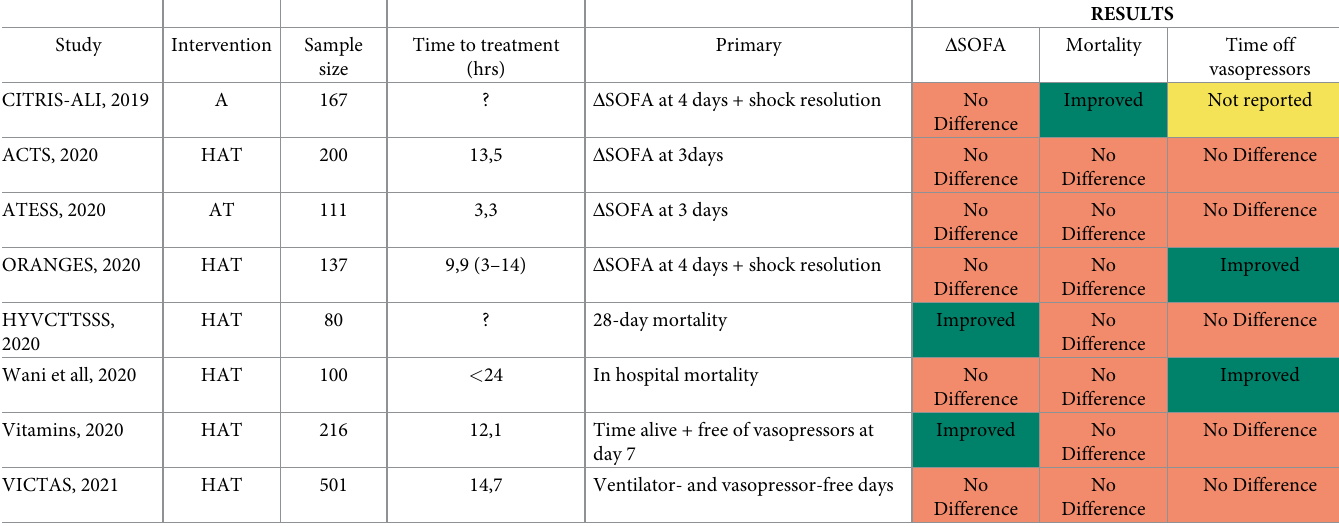
Table 1. Summary of RCTs evaluating Vitamin C or HAT therapy (Hydrocortisone, Ascorbic Acid and Thiamine) in sepsis and septic